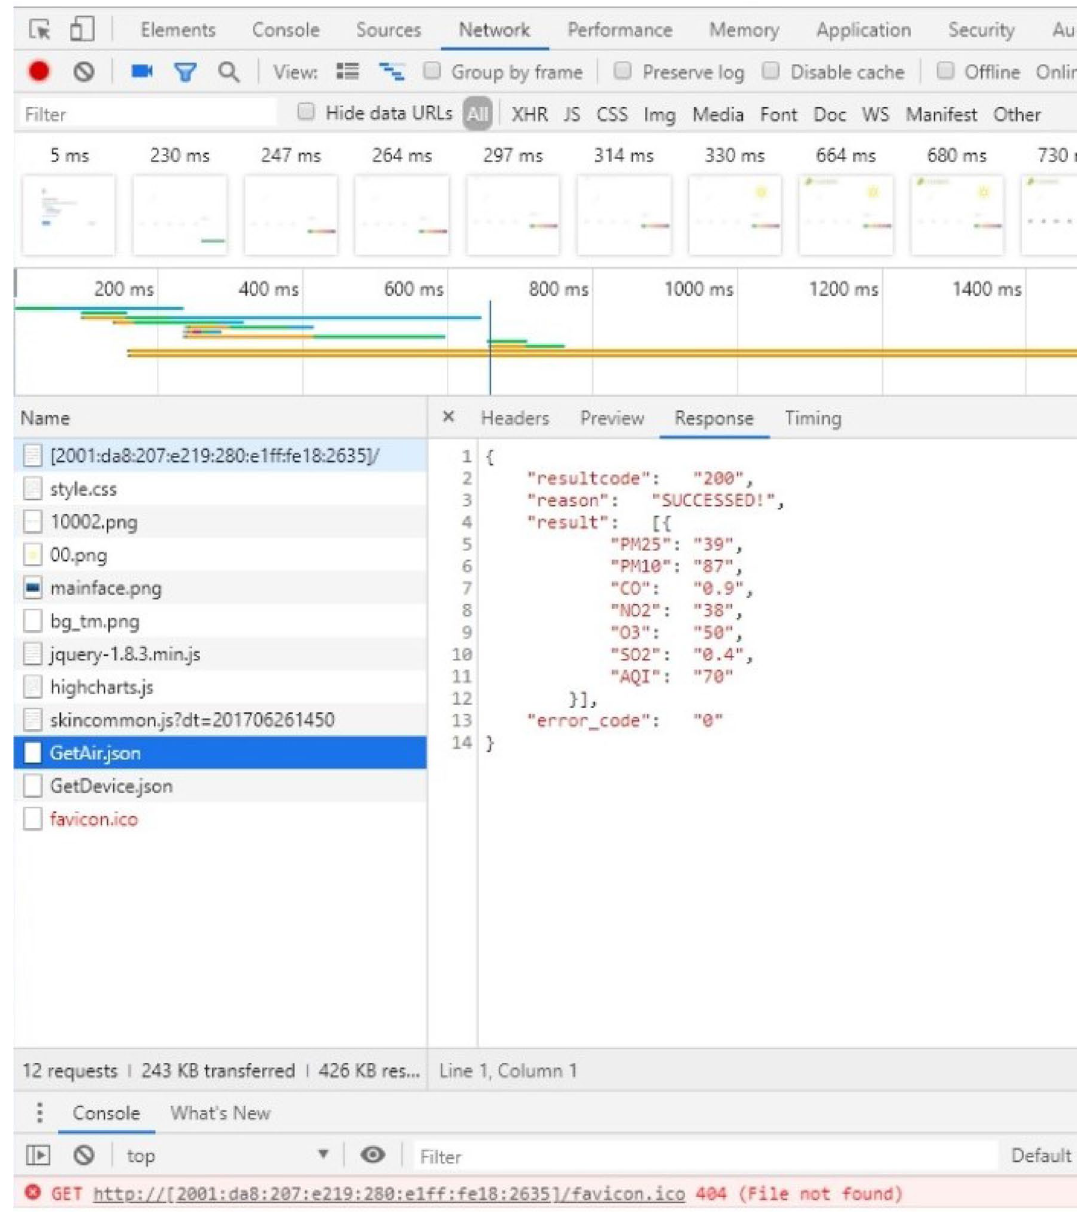
Figure 15. Embedded web page data request to receive test